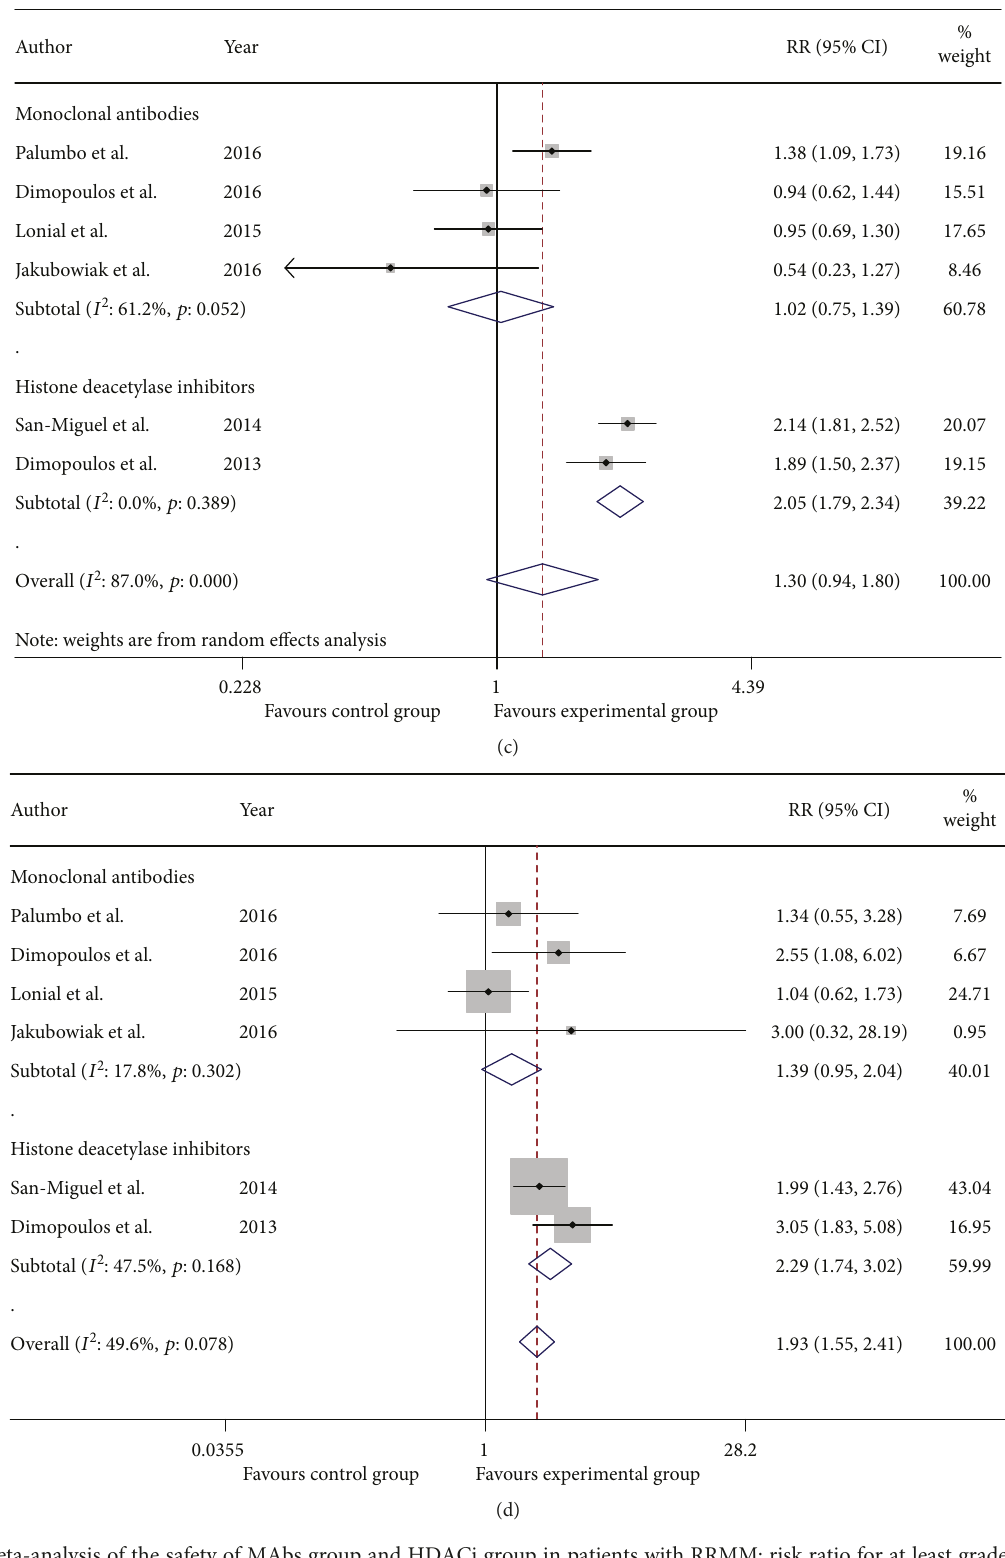
Figure 5: Meta-analysis of the safety of MAbs group and HDACi group in patients with RRMM: risk ratio for at least grade 3 anemia (a), neutropenia (b), thrombocytopenia (c), and sense of fatigue (d) of MAb group and HDACi group versus their corresponding control group. “ P = 0 000 ” in Figure 5(b) and Figure 5(c), which was automatically generated by Stata software, represents p ≤ 0 001 actually, denoting that there exists heterogeneity among